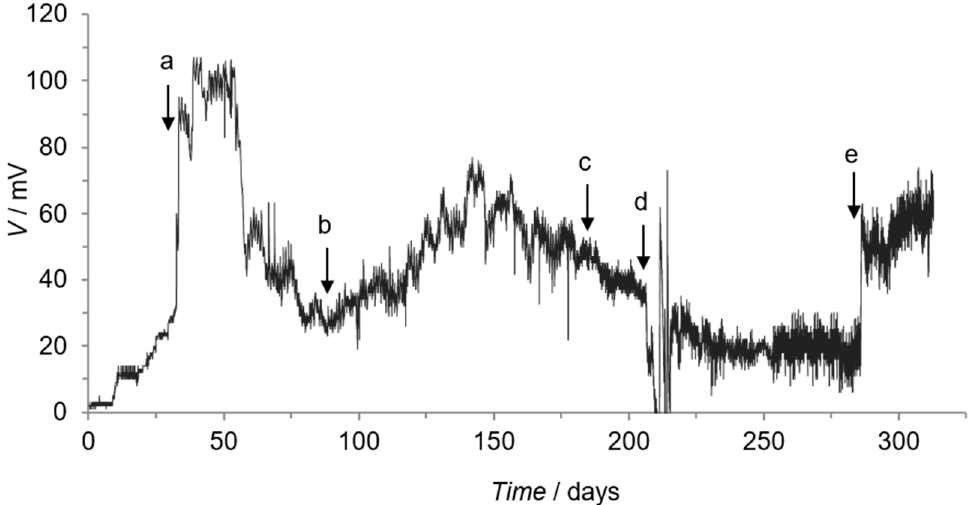
Figure 2. Variation of voltage over SMFC operation; (a) change of external resistance; (b) introduction of new carbon Toray anode in sediments; (c) cathode switch from carbon Toray to stainless steel electrode; (d) addition of acetate in the water column; (e) switch of electrodes, the cathode was introduced in the sediments (as a new anode) and the anode was placed in the water column (in order to be used as a new cathode).